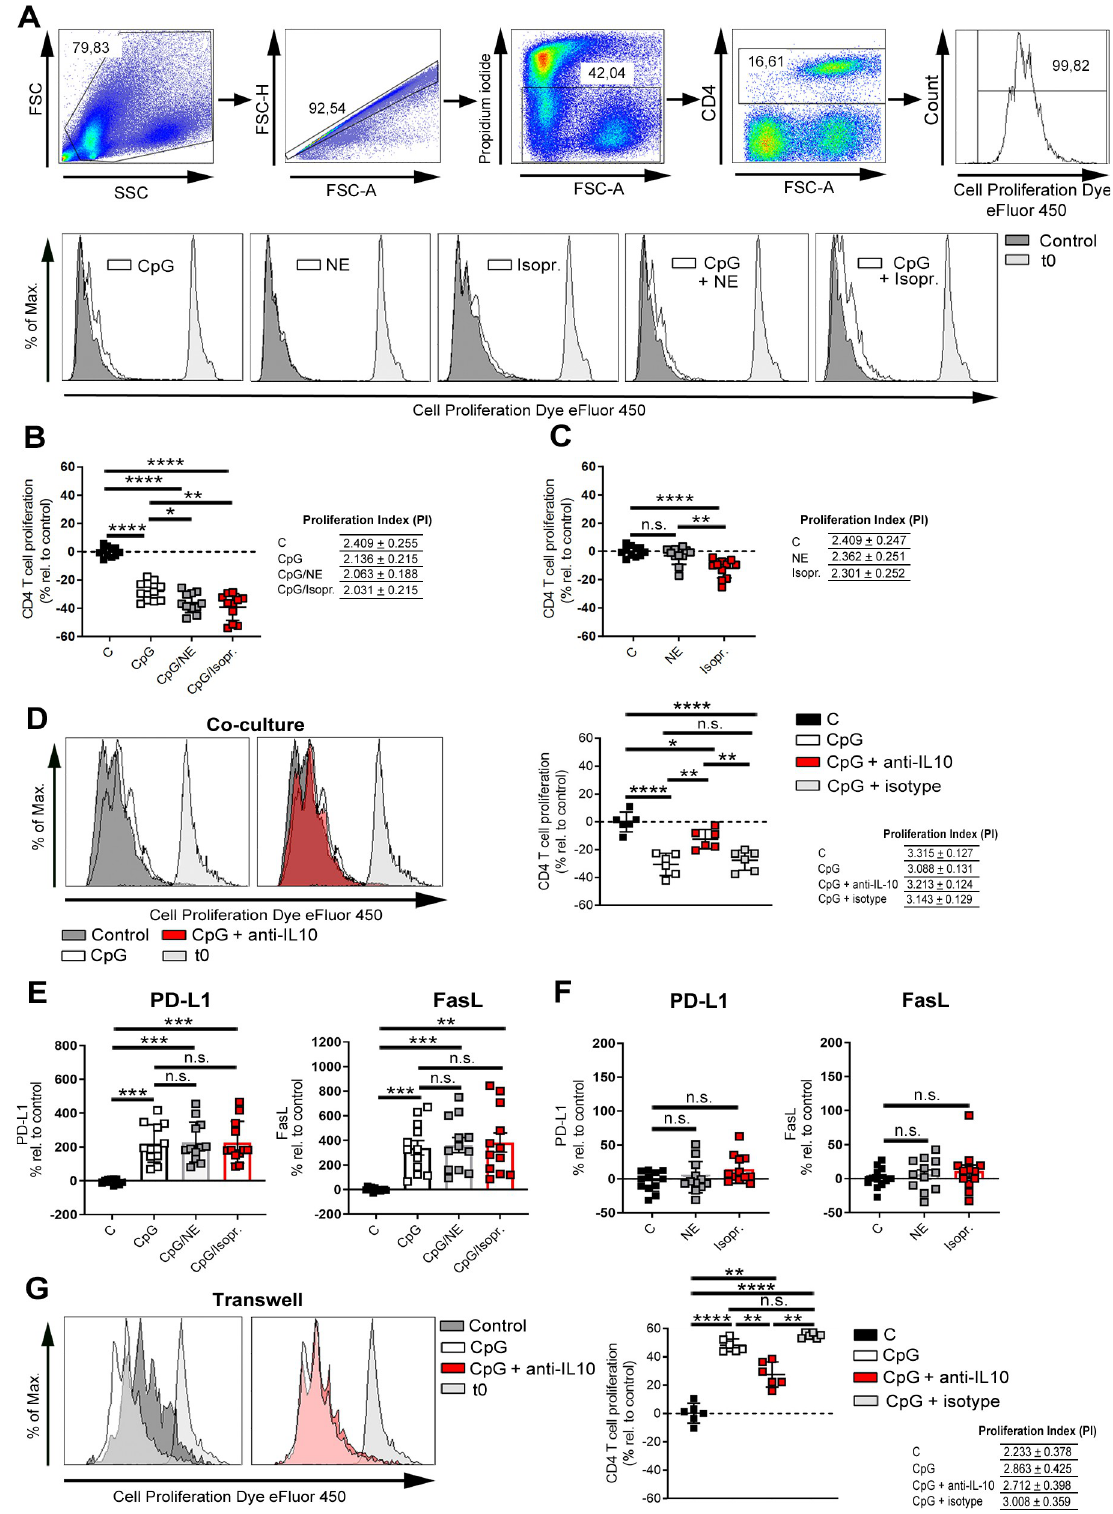
Fig 7. IL-10 improves Breg function to suppress T cells. ( A – G ) DBA/1J mice were immunized with 100 μ l of an emulsion of CII and CFA. After 14–21 days, splenic B cells from immunized mice were isolated by MACS and B cell–depleted splenocytes were used